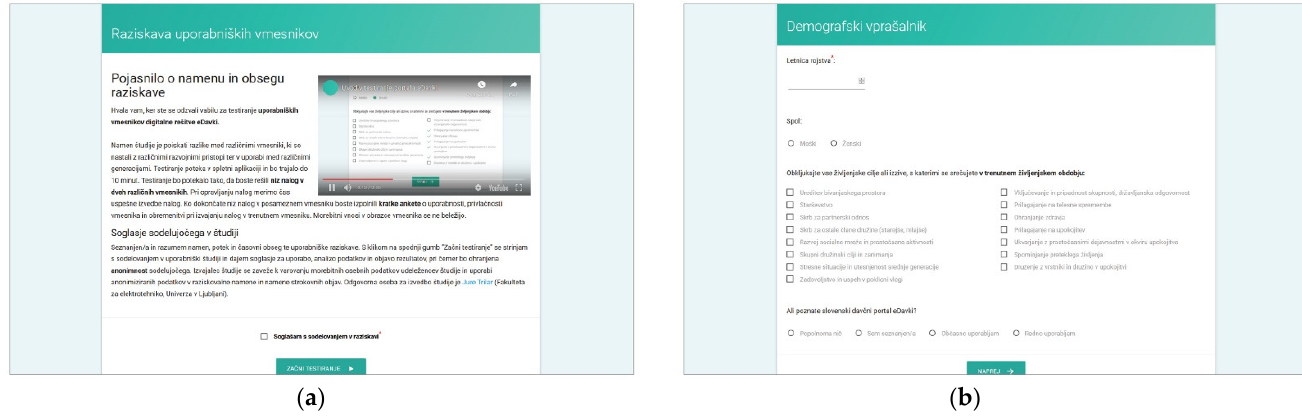
Figure 2. Testing platform interface displaying ( a ) introductory text with user agreement dialog, and ( b ) demography, generation developmental task and familiarity with the solution questionnaire.